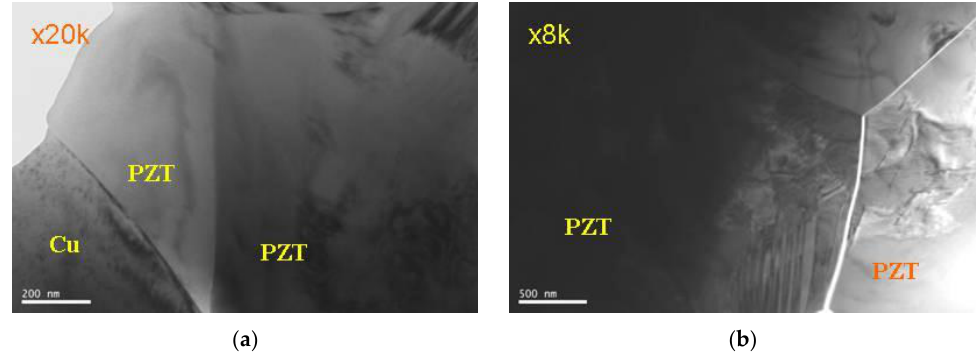
Figure 6. TEM micrograph of ( a ) Cu-PZT interface, ( b ) triple points and grain boundaries near electrode [38].